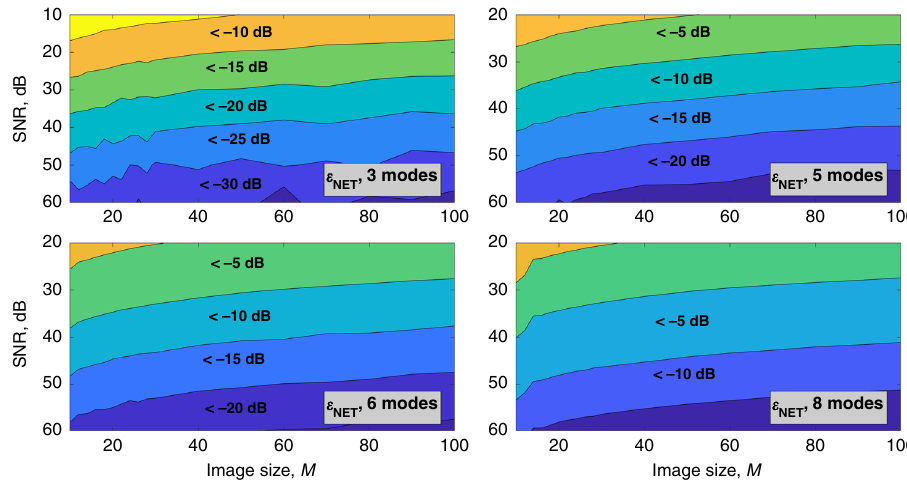
Fig. 6 Dependence of the net decomposition error on noise level and image size. Net decomposition error ε NET for a 3-mode, b 5-mode, c 6-mode, and d 8-mode fi bers depending on image size and noise level in the input image. Horizontal axes correspond to image size in pixels, vertical axes correspond to SNR value in dB. Net decomposition error values are color-coded, regions with an error value less than a certain value are labeled on the graphs. Source data are provided as a Source Data fi le.